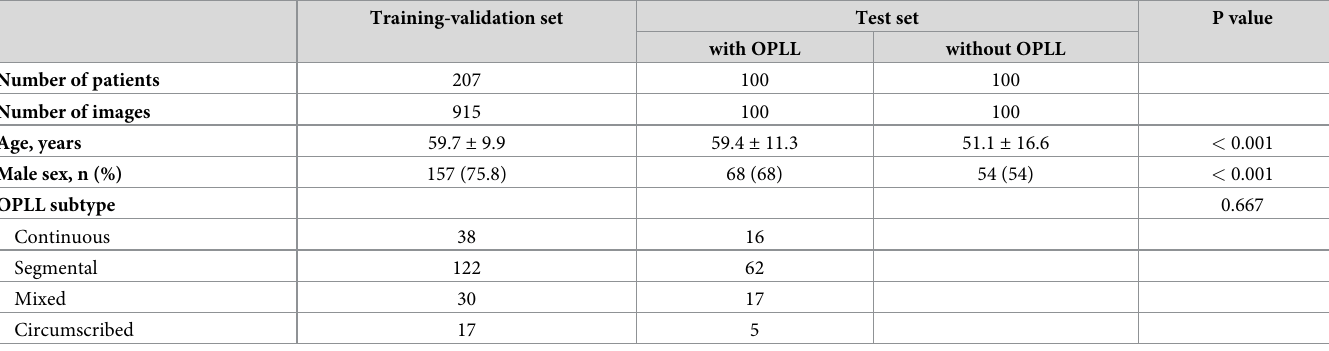
Table 1. Patient